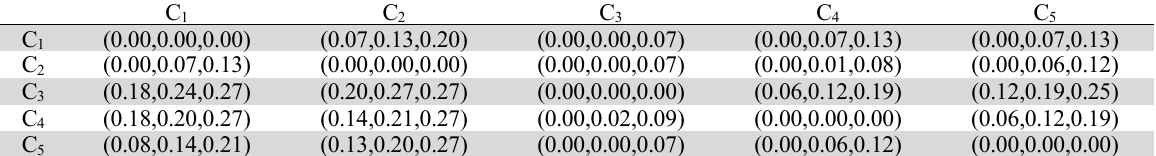
Normalized direct-relation fuzzy